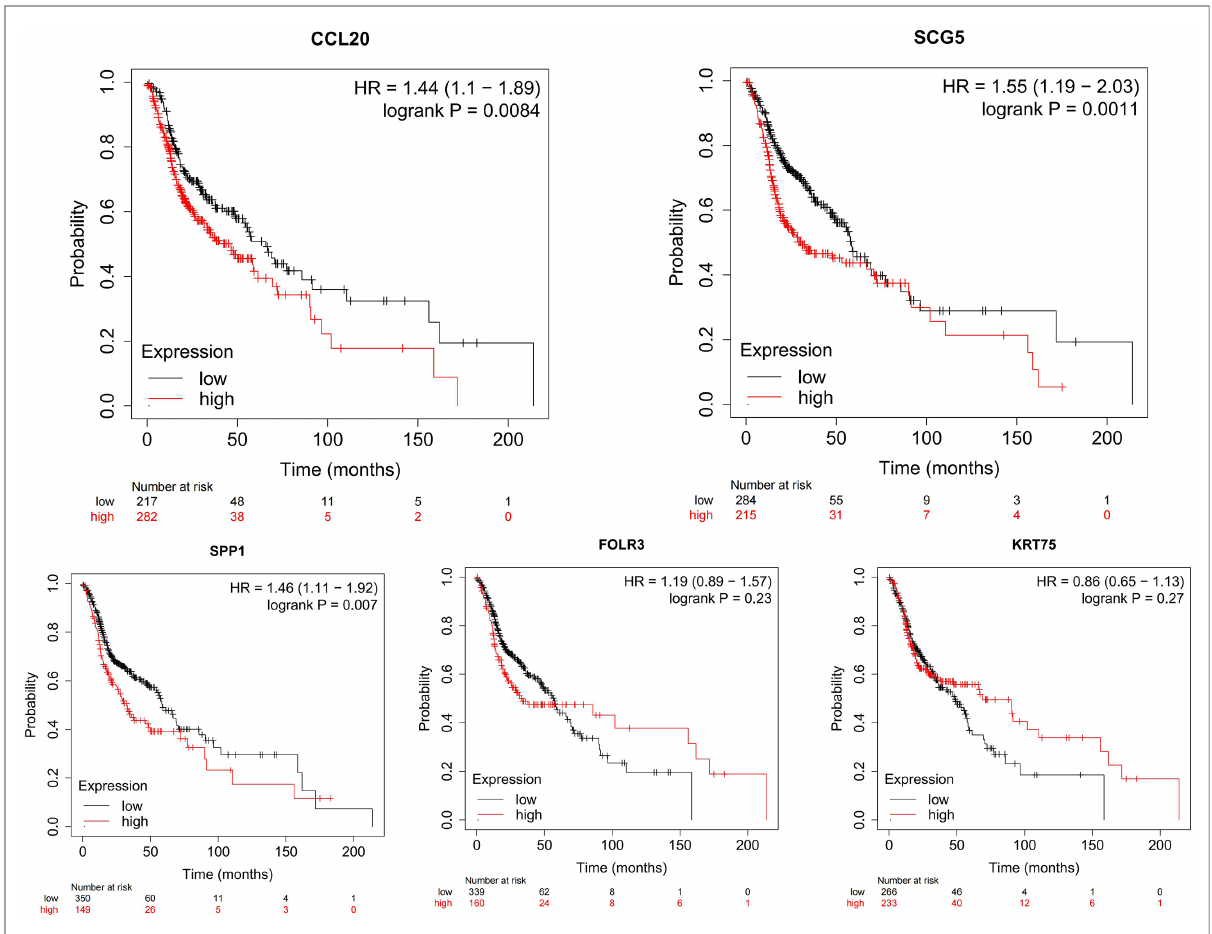
FIGURE 9 Using Kaplan – Meier Plotter website to identify the relationship between the expression of CCL20 , SCG5 , SPP1 , FOLR3 , and KRT75 genes and prognosis in